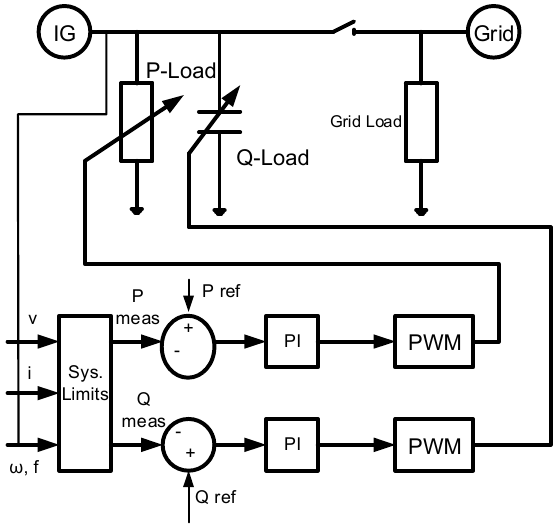
Figure 14. Schematic of the IG closed loop control during islanding.